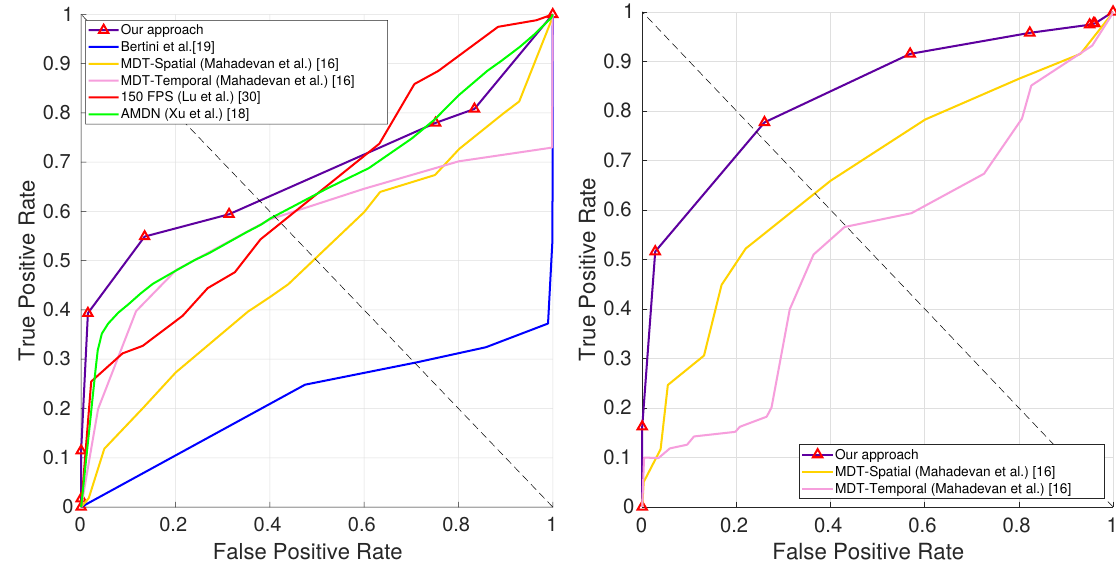
Figure 4. Pixel-level TPR-FPR curves comparing our approach with various well-known methods in the Ped1 ( left ) and Ped2 ( right ) settings. Table 4. Rate of Detection (RD) comparison of our method versus various well-known state-of-the-art techniques on the Ped1 and Ped2 (where available) settings with frame-level and pixel-level